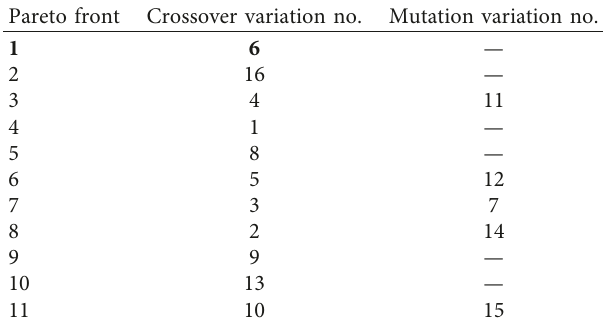
Table 6: NSGA of crossover and mutation variations. Pareto front Crossover variation no. Mutation variation no.